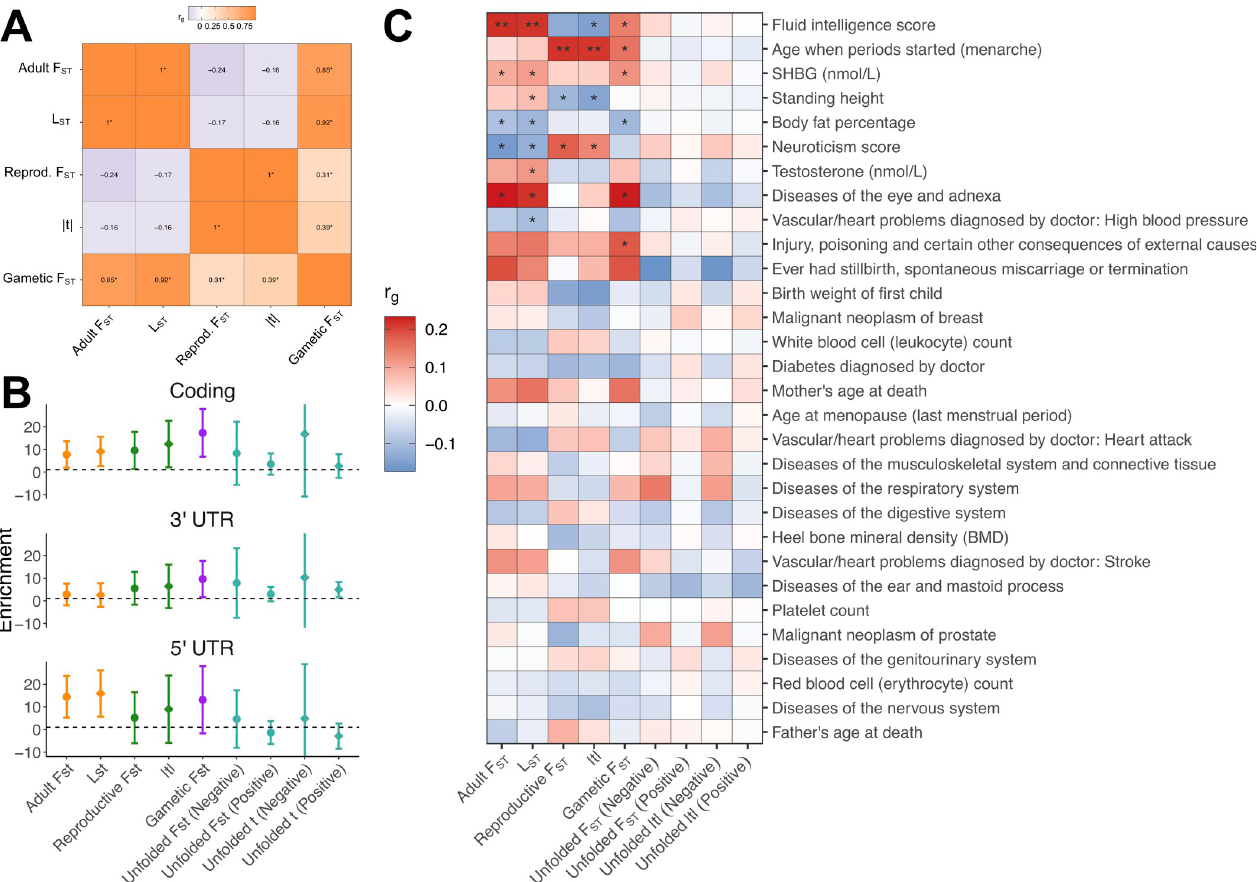
Fig 5. Indications that sex-differentiated loci are more likely to be functional and contribute to trait variation. ( A ) Genetic correlations between metrics of sex-differential selection. Positive correlations (orange) imply that alleles have similar sex-specific effects on given fitness components, while negative correlations (purple) imply that alleles have opposing sex-specific effects on given fitness components; � denotes unadjusted p < 0.05. ( B ) Enrichments ( ± SE) of sex-differentiated loci in major functional categories. For each metric, enrichments were calculated as the relative SNP heritability (as a fraction of total SNP heritability) explained by a given functional category, divided by the relative number of SNPs (as a fraction of all SNPs) present in a given functional category. Dashed line = 1 (no enrichment). “Negative” and “Positive” refer to negative and positive values (i.e., SA and SC components, respectively) of unfolded reproductive ^ F and unfolded t metrics. ( C ) Genetic correlations between metrics of sex-differential selection and various UK Biobank phenotypes (as ST analysed by the Neale laboratory). Metrics of sex-differential selection have been polarised, such that positive correlations (red) suggest that higher trait values are more beneficial to females than males (for the relevant fitness component), while negative correlations (blue) suggest that higher trait values are more beneficial to males than females (see Discussion for caveats surrounding this interpretation); �� denotes FDR-adjusted p < 0.05 and � denotes unadjusted p < 0.05. The code needed to generate this figure can be found at https://github.com/filipluca/polygenic_SA_selection_in_the_UK_biobank and https://github. com/lukeholman/UKBB_LDSC, with data at https://zenodo.org/record/6824671. FDR, false discovery rate; SA, sexually antagonistic; SC, sexually concordant; SNP, single-nucleotide